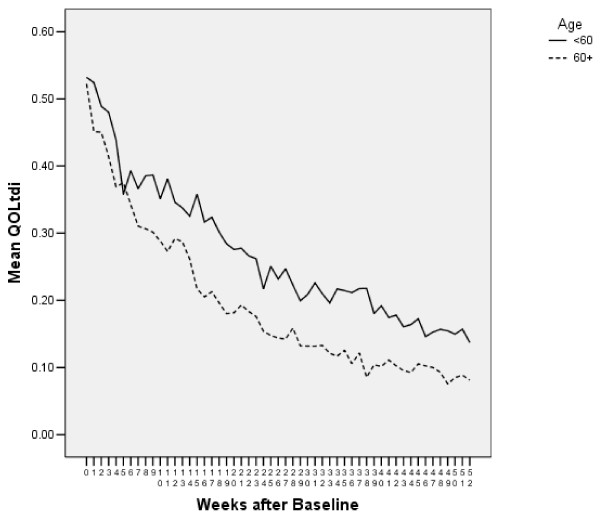
Mean QOLtdi in 12 months after baseline, by age (N = 115). The dotted line is age ≥ 60, the solid is age < 60.